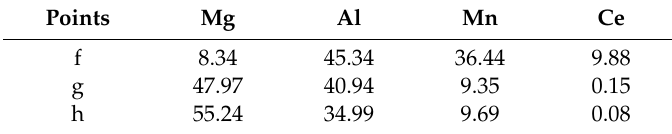
Table 3. EDS results with the element atomic percentage of points in Figure 6b,d (at